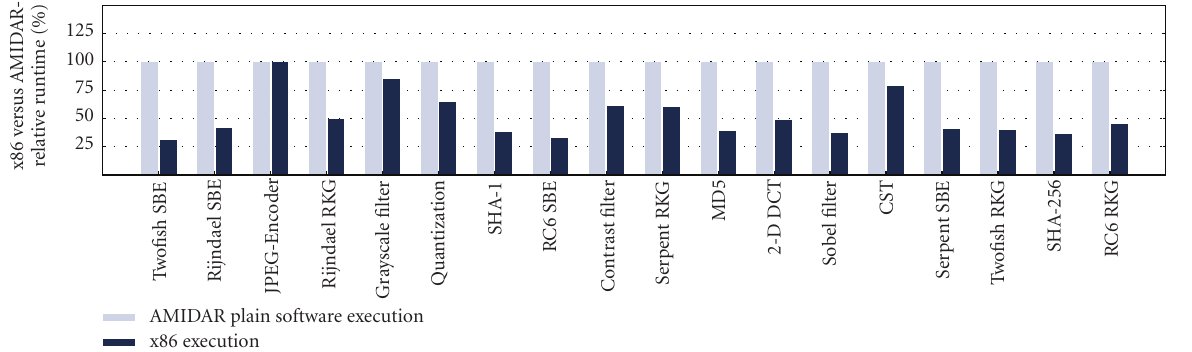
Figure 5: Runtime comparison of AMIDAR based Java processor and x86 Intel Core 2 Duo @